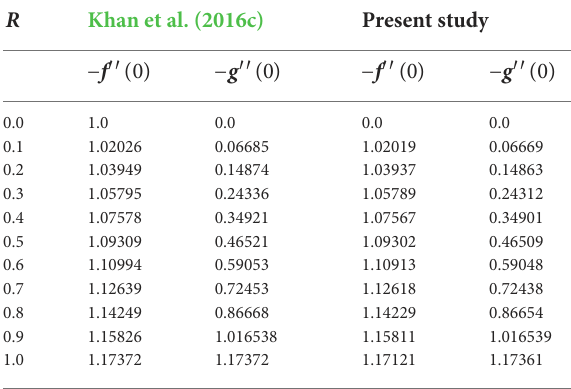
TABLE 1 An evaluation table for − f ′′ (0) and − g ′′ (0) for several magnitudes of R in reduced case when β 1 = β 2 = M = 0. R